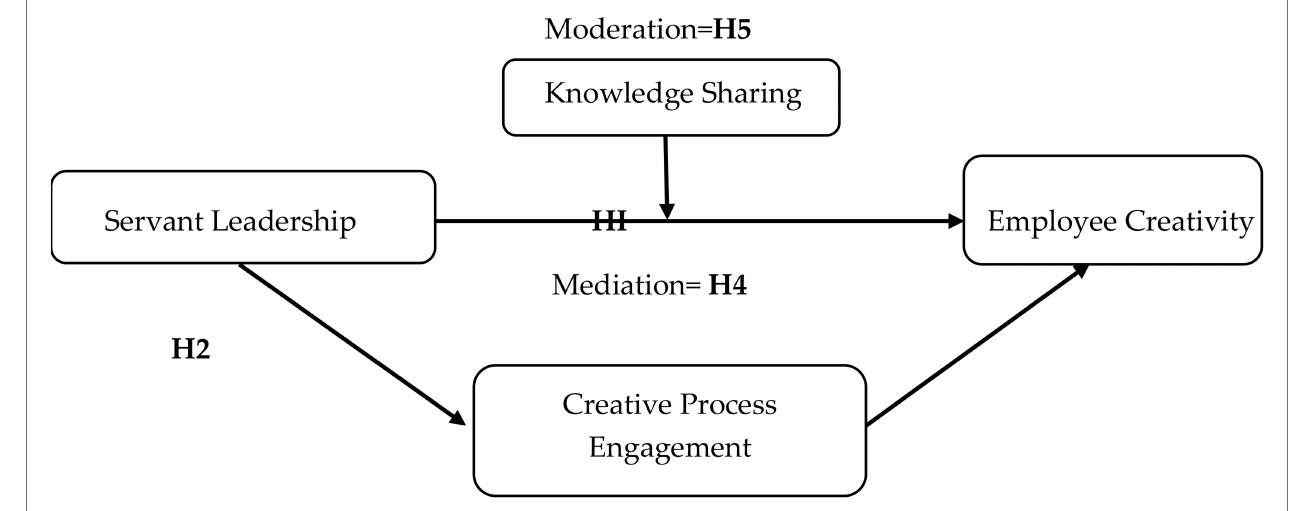
FIGURE 1 | Conceptual model.